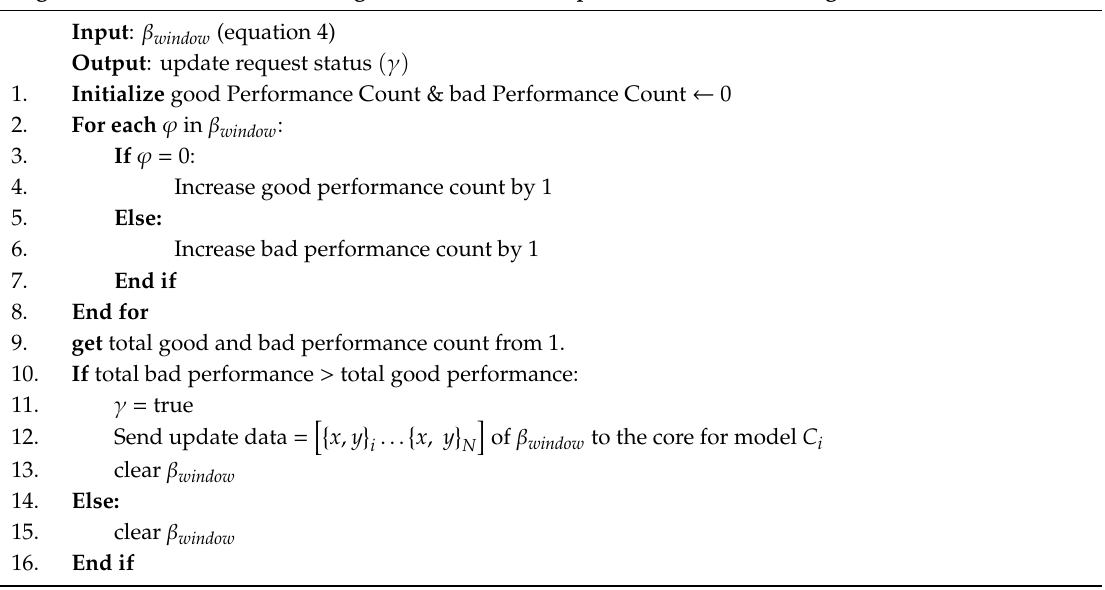
Algorithm 1. Model evaluation algorithm (on the smartphone at the network